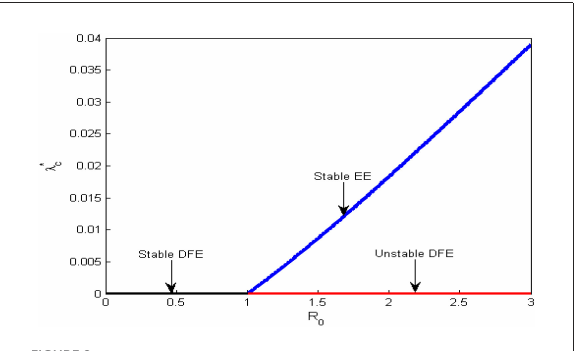
FIGURE2 Bifurcation plot for the dynamics of